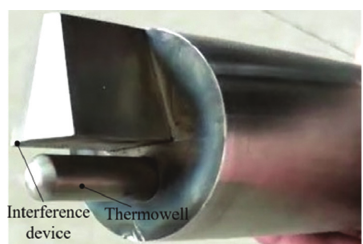
Figure 27: Thermowell with interference